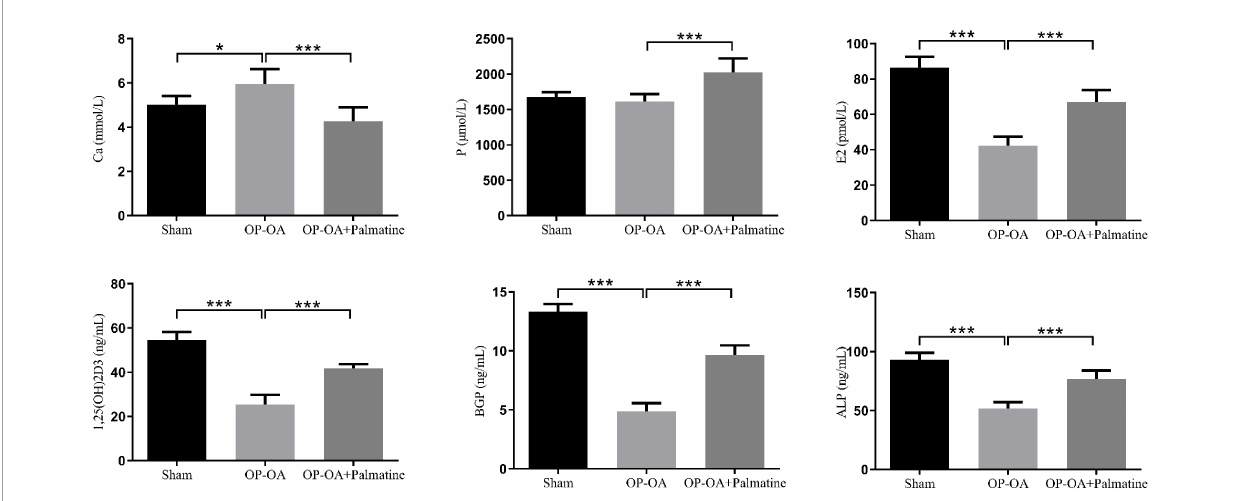
FIGURE3 Effect of PAL on bone metabolism in OA-OP rats. Quantitative analysis of serum levels of E2, ALP, BGP, 1,25(OH)2D3, Ca, and P. *Statistically significant difference ( P < 0.05). **Statistically significant difference ( P < 0.01). ***Statistically significant difference ( P <